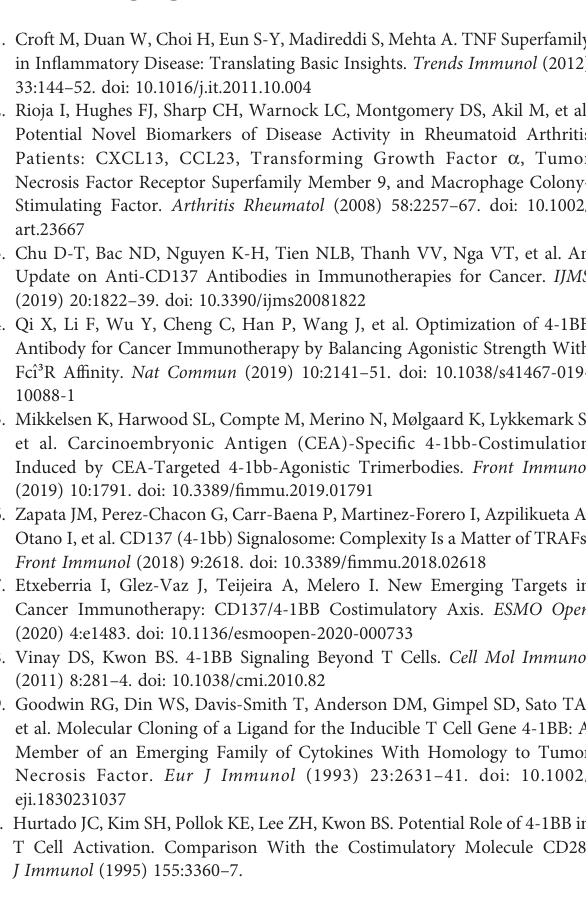
Second bar represents a ratio of cells cultured with laminin but without 4-1BBL stimulation. *P < 0.05. Supplementary Table 1 | Average calculated KD-values (µM) for 4-1BB toward different galectins measured with fl uorescence anisotropy. Two experimental replicateswereusedforcalculatingtheaverageK d -values.Between0.2and2.5µM of each galectin with 0.02 µM of corresponding fl uorescence probe was tested in the presence of a range of concentrations (0.07-4.75 µM) of (rh)4-1BB or (rh)IgG1 Fc; anisotropy was measured and average K d -values were calculated (in total 6-20 (rh)4-1BBconcentration measuringpoints generating ≥ 15%inhibitionwereused to calculate the average K d -values). All galectins were tested against the same applicable. Supplementary Table 2 | Characteristics of included patients with rheumatoid arthritis (RA). Data are expressed as % or median (IQR). DAS28CRP, disease activity score 28 based on CRP; RA, rheumatoid arthritis. Seropositive: Presence of IgM-rheumatoid factor or anti-citrullinated protein antibodies. DAS28CRP: Disease Activity Score-28 for Rheumatoid Arthritis with CRP. Supplementary Table 3 | Related to Figure 1C . The raw data of the microarray analysisofgalectin-3andgalectin-9at50 m g/mlintheN-glycanarray,meanandSD among the values offour replicate spots. Gal-3 data were previously published (27). The structures speci fi cally-bound by Gal-3 and Gal-9 are highlighted in Blue and Green,